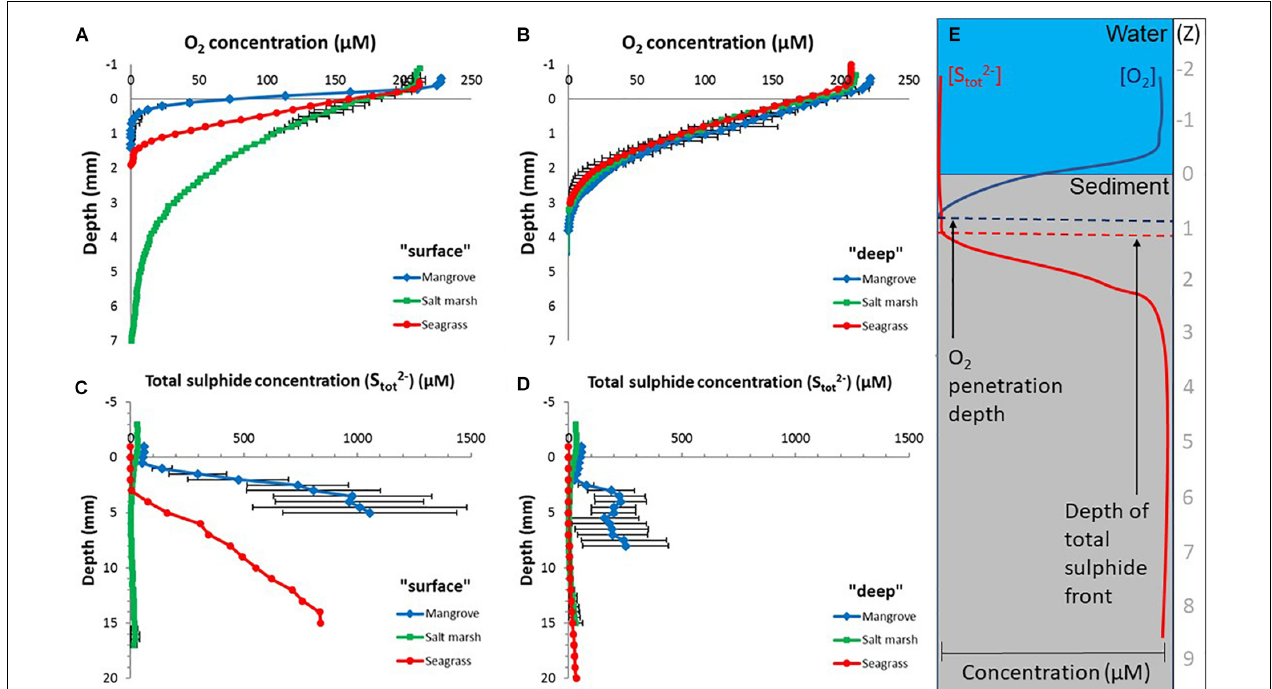
FIGURE 2 | Depth microprofiles of the O 2 and total sulfide (S tot 2 - ) concentration within sediments originating from mangrove, salt marsh, and seagrass ecosystems (Sydney area, NSW, Australia). (A) O 2 microsensor measurements in the sediment surface (“surface”; 0–10 cm depth). (B) O 2 microsensor measurements in deeper sediment layers (“deep”; > 50 cm depth). Microsensor profiling was performed down to 1 to 2 cm depth within each sediment core, depending on the sediment O 2 consumption. (C) Total sulfide measurements in the sediment surface (“surface”; 0–10 cm depth). (D) Total sulfide measurements in deeper sediment layers (“deep”; > 50 cm depth). Microsensor profiling was performed within the top ∼ 0–2 cm depth of each “surface” and “deep” sediment core, depending on the sulfide concentration. The total sulfide concentration was calculated from the measured H 2 S and pH microprofiles, as shown previously by Kühl and Jørgensen (1992). Legends depicts the investigated vegetated coastal habitat (VCH). Symbols and lines represent mean values ± SEM; n = 6–9, technical replicates (biological replication of 2–3). (E) Schematic diagram of O 2 and total sulfide microprofiles in sediment, showing examples of the O 2 penetration depth and thus the oxic/anoxic interface, as well as, the depth of the sulfide front. Z indicates the vertical sediment depth in mm. TABLE 1 | O 2 penetration depth and depth of total sulfide front within the investigated vegetated coastal habitats (i.e., seagrass meadow, salt marsh and mangrove ecosystems originating from the Sydney area, NSW, Australia). O 2 penetration depth Depth of sulfide front Ecosystem (mm) (mm) Surface Deep Surface Deep Mangrove 0.8 ± 0.2 2.7 ± 0.6 0.7 ± 0.2 3.2 ± 1.2 Salt marsh 5.3 ± 1.1 3.3 ± 0.1 10.3 ± 1.7 Seagrass 1.6 2.9 ±